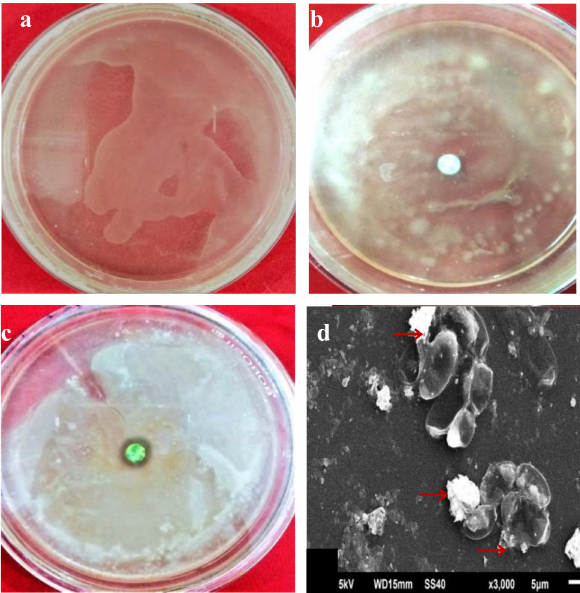
Figure 5. Antibacterial activity, ( a ) bacteria on nutrient agar media, ( b ) no inhibition zone (media without AgNPs), ( c ) Inhibition zone present in AgNPs treated media, and ( d ) SEM image showing disrupted and dead bacteria